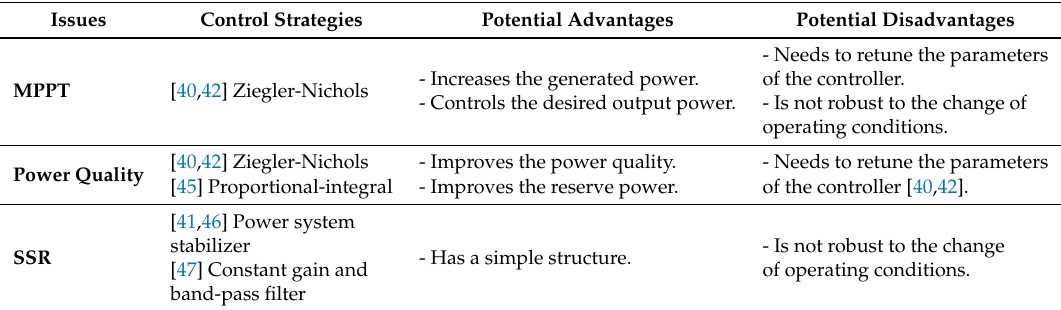
Table 2. Supplementary controllers for Type II wind turbines.